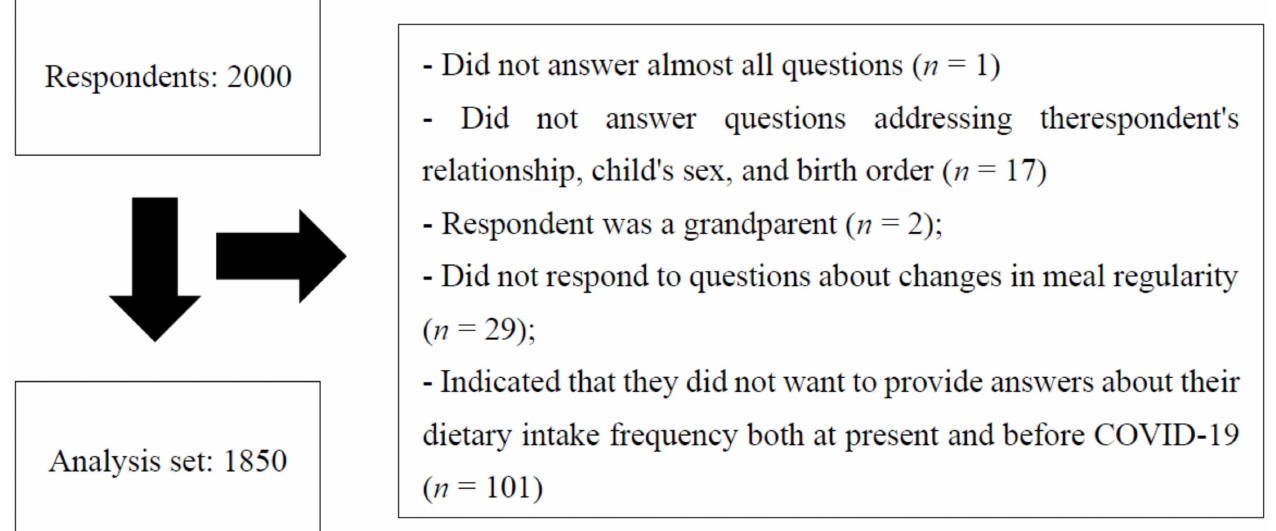
Figure 2. Participant